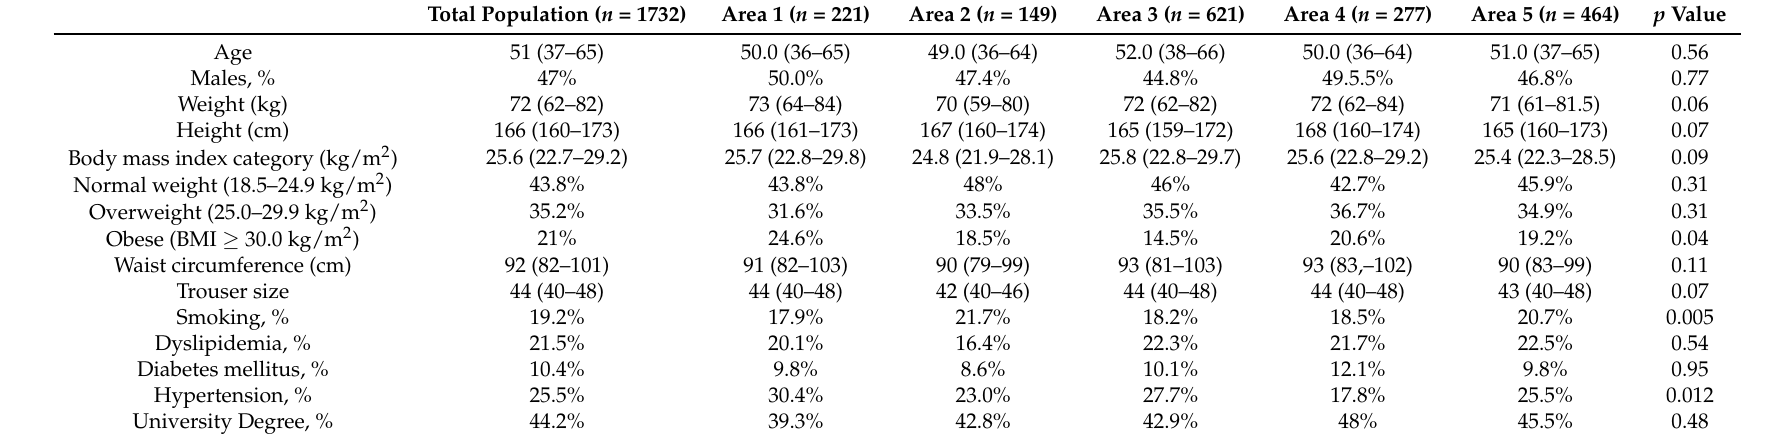
Data are presented as median (interquartile range) for non-normally distributed variables. Comparisons are assessed by Kruskal-Wallis